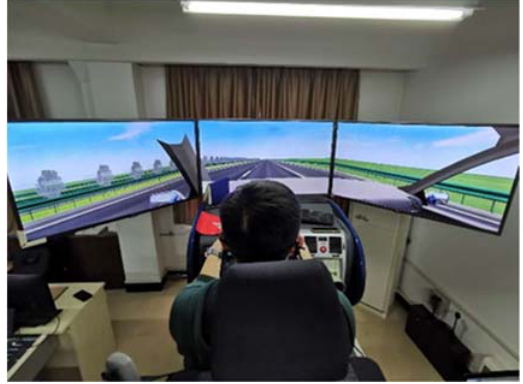
Figure 2. Driving simulation